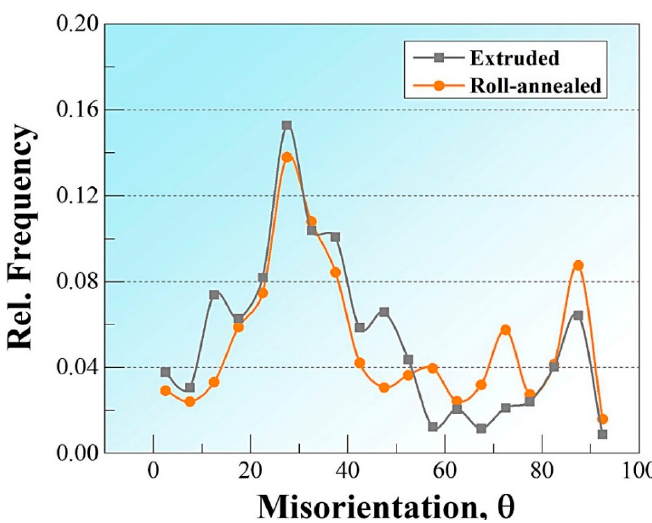
Figure 9. Distributions of grain boundary misorientations of the extruded sample and the rolling- annealed sample.